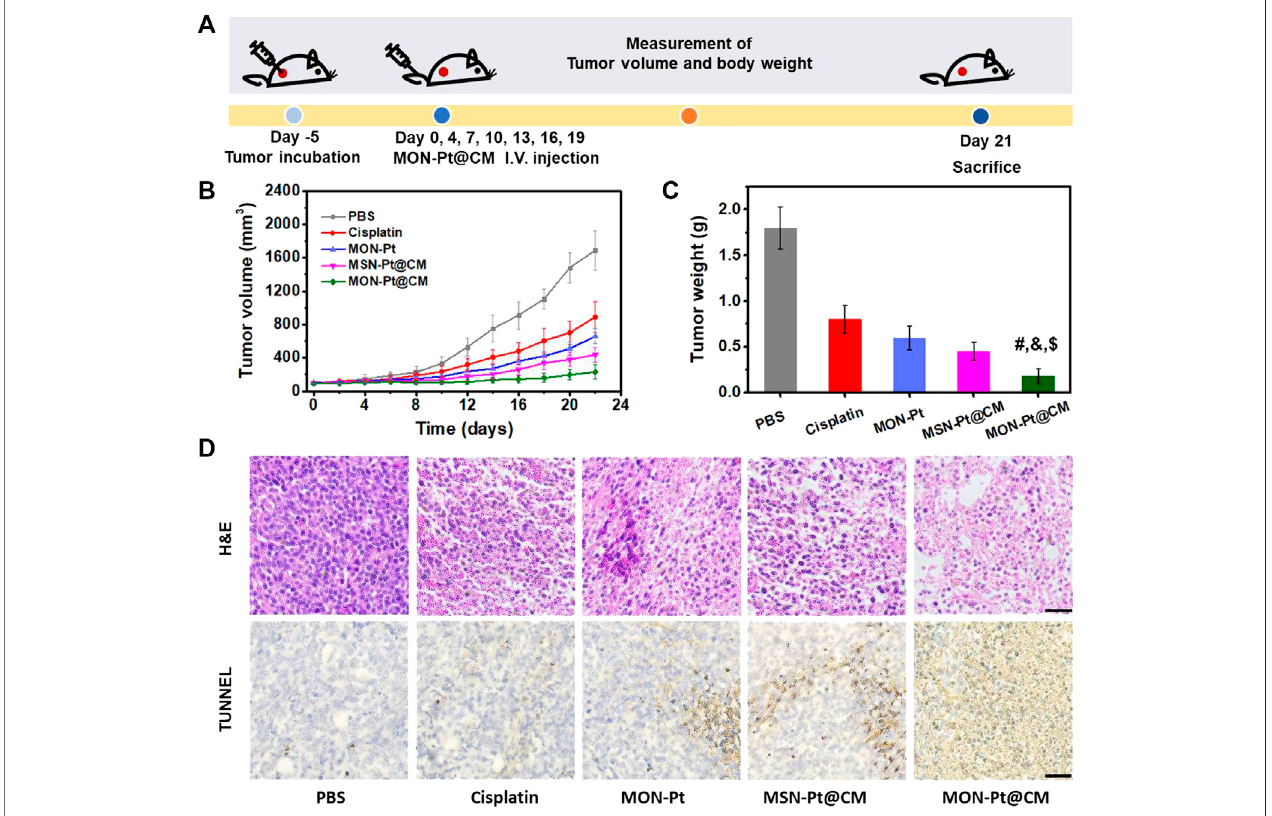
FIGURE 5 | MON-Pt@CM mediated chemotherapy in vivo . (A) Schematic of treatment schedule in 4T1 bearing tumor model. (B) Tumor volume and (C) tumor weight. (D) H&EstainandTUNELpositivecellsofthetumor.Scalebarsindicate50 µm #,&,$ p < .05compared withPBSgroup( $ ),cisplatingroup( # ),andMSN-Pt@CM group ( &